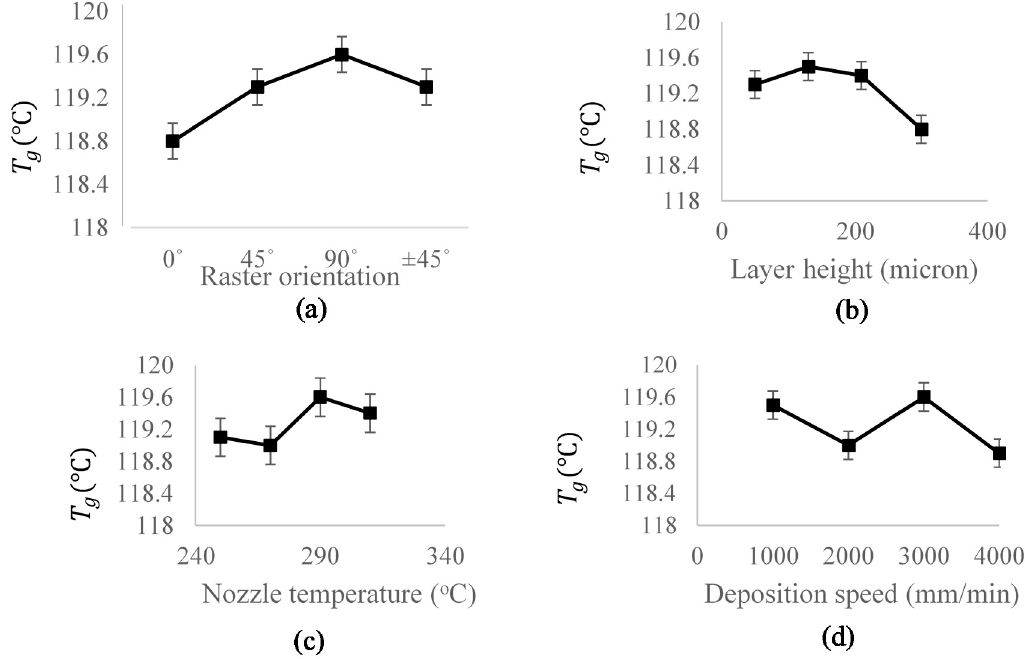
Figure 7. The variation of glass transition temperature of FDM processed ABS as a function of: ( a ) Raster orientation; ( b ) Layer height; ( c ) Nozzle temperature; ( d ) Deposition speed. Note that the presence of air gap (or inversely an overlap) between the printed roads would make a major differ- ence in ensuing macro-level properties and non-linearities observed in the response above, and other mechanical properties as also reported by [19]. The curved shown are average values from all the performed 16